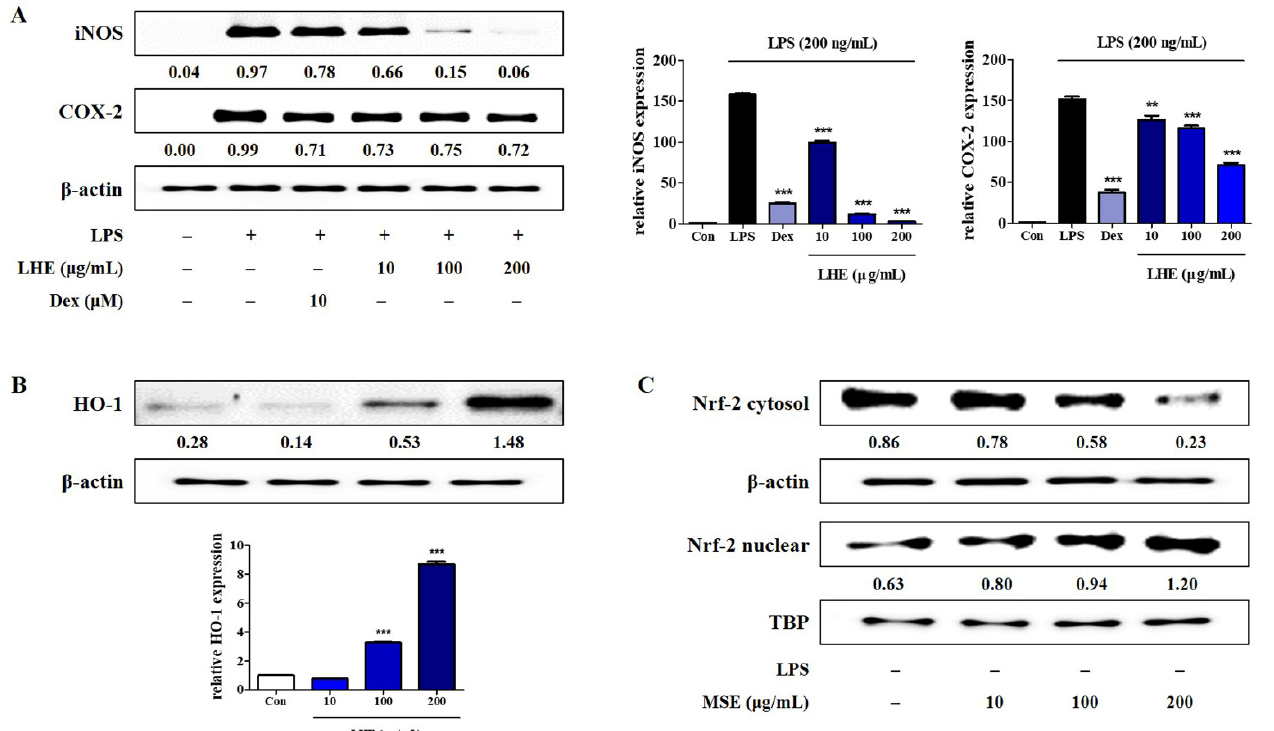
Figure 2. Effects of LHE on ( A ) iNOS and COX-2 expression, ( B ) HO-1 induction, and ( C ) nuclear translocation of Nrf-2 in RAW 264.7 macrophages. ( A ) Cells were incubated with LHE for 1 h and then stimulated with LPS for 24 h (protein) or 12 h (mRNA). Cells were incubated with LHE alone for ( B ) 6 h or ( C ) 3 h. The quantified number and histograms showed the expression levels of protein and mRNA relative to those of β -actin or TBP. ** p < 0.01 and *** p < 0.001 were calculated by comparing LPS stimulation values.